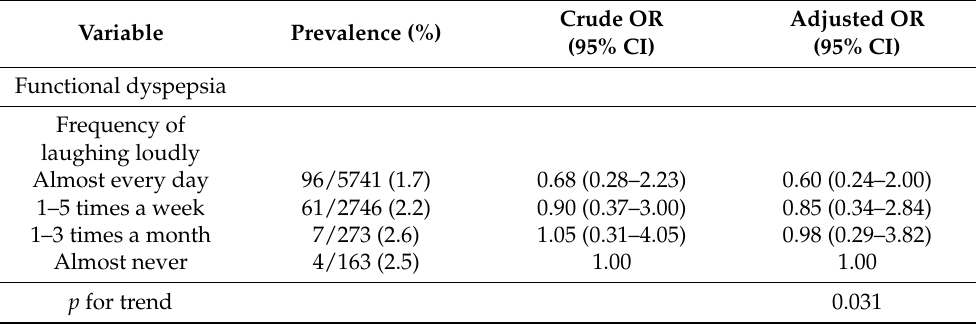
Table 2. Crude and adjusted odds ratios and 95% confidence intervals for functional dyspepsia in relation to frequency of laughing loudly.